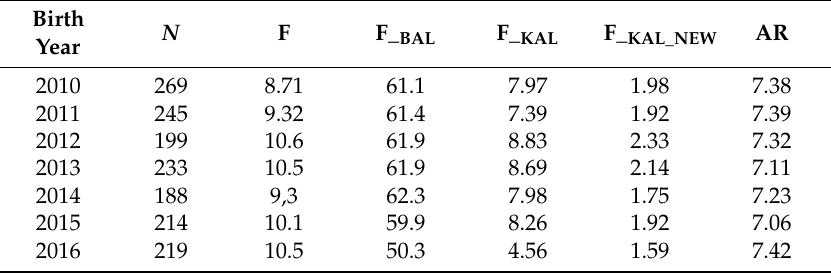
Table 3. Inbreeding (F) and average relatedness (AR) of the reference population.